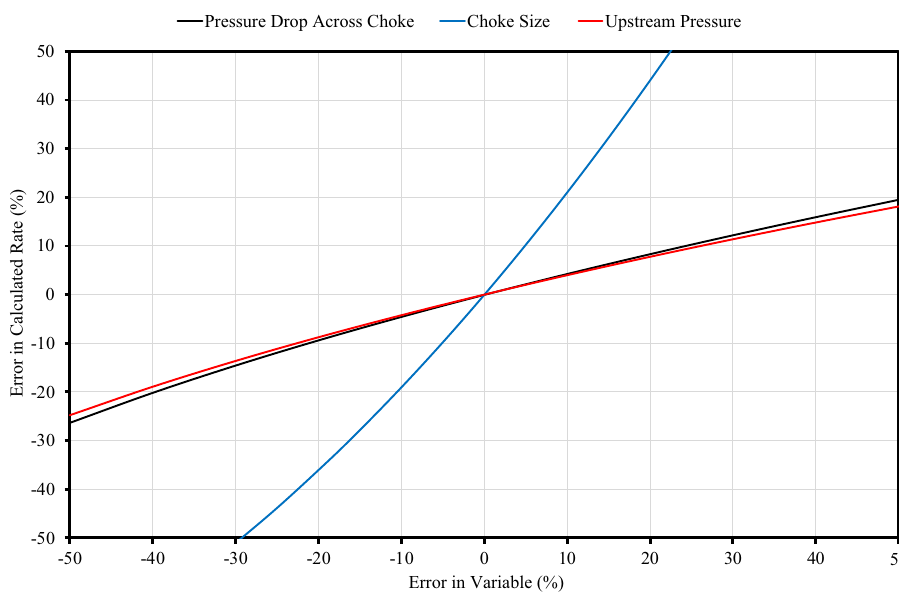
Fig. 5 Effect of error in a few variables on the error in calcu- lated rate based on Eq.